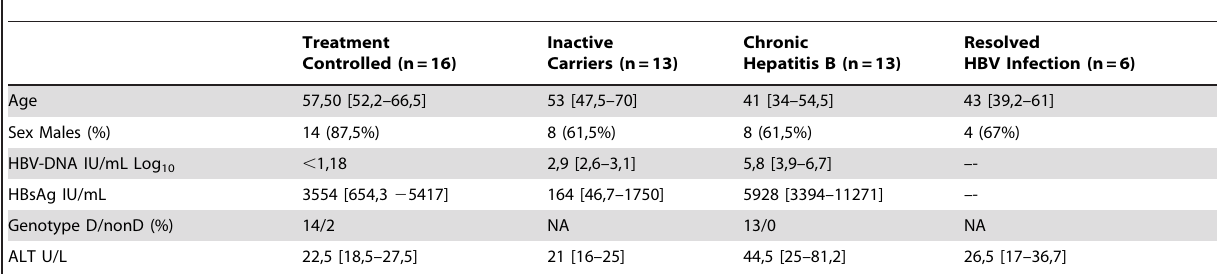
Table 1. Main serovirological and biochemical features of included patients.